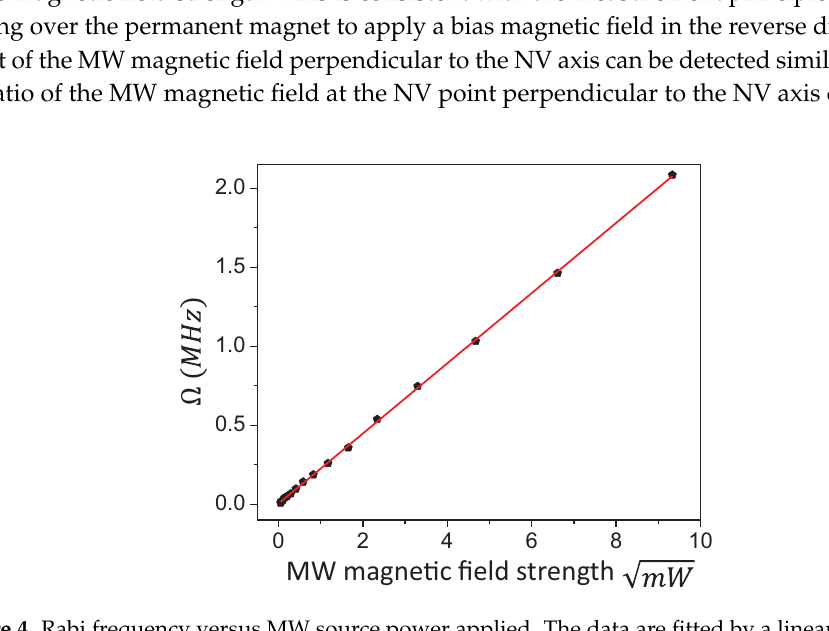
Figure 4. Rabi frequency versus MW source power applied. The data are fitted by a linear